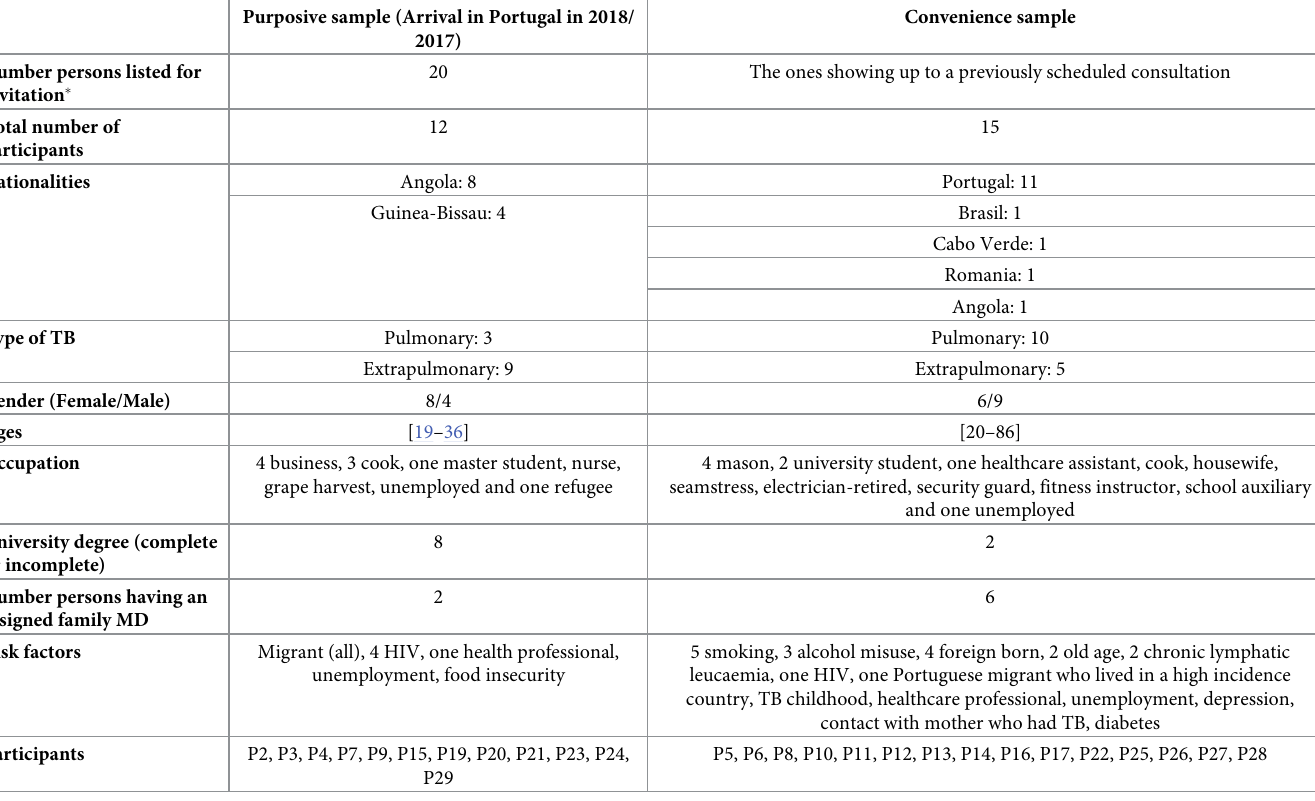
Table 1. Characteristics of study participants according to sampling